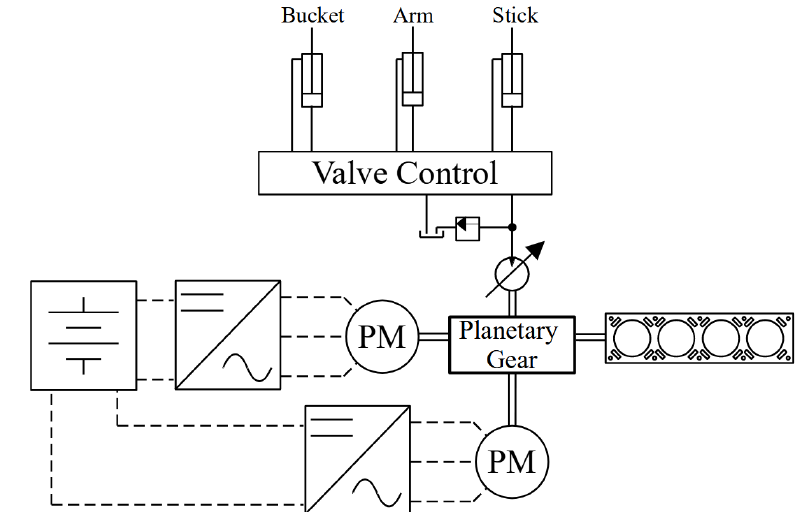
Figure 4. Series-parallel configuration applied to the implements of a